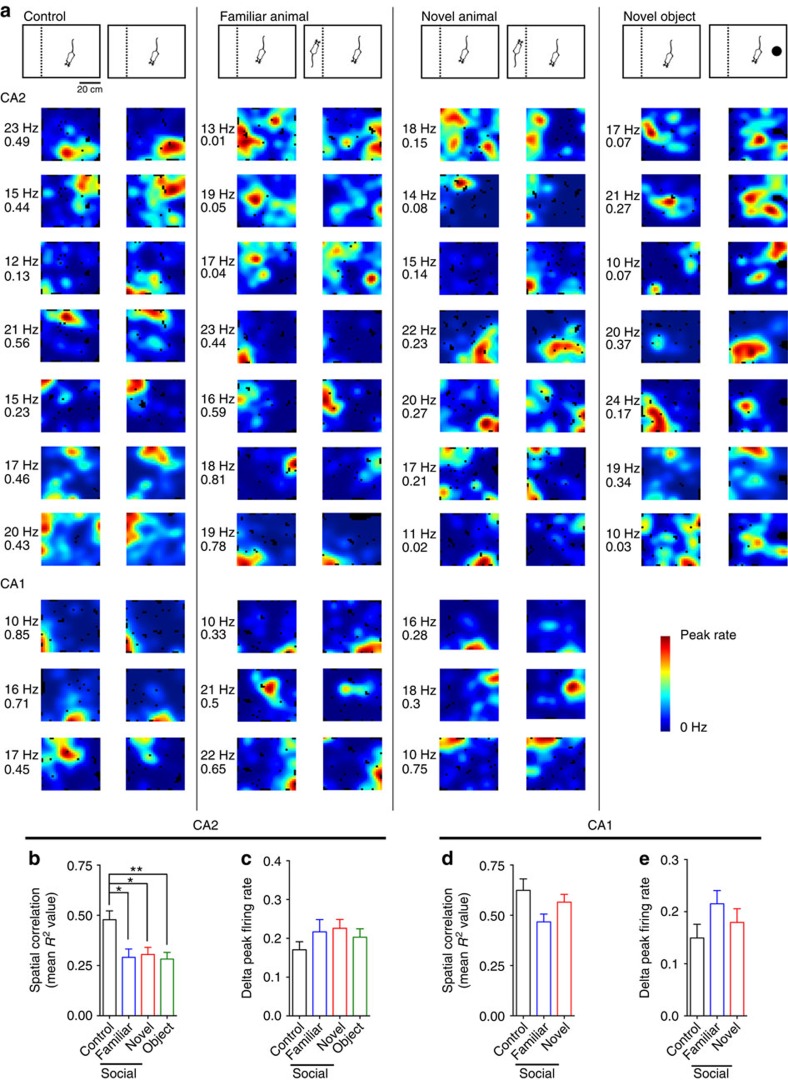
CA2 globally remaps on exposure to social and contextual stimuli.(a) Example place maps for CA2 neurons (top) and CA1 neurons (bottom) on exposure to each of the four conditions depicted in the diagrams on top. In the first epoch of each of the four conditions, animals explored the open-field arena with no stimulus present. In the second epoch, animals were exposed to no stimulus (control), a familiar rat, a novel rat or a novel object. Stimulus rats were placed in a clear plexiglass chamber and novel objects were placed inside the open-field arena. For each place field map pair, the peak firing rate for the pair (in Hz, top) and the spatial correlation value (bottom) is listed to the left and heat maps for both place field maps are scaled to the peak rate. (b,c) Analyses of remapping of firing fields by CA2 neurons on the four exposures listed, including spatial correlations to measure global remapping (b) and changes in peak firing rates (c). CA2 place cells globally remapped their representation of space in response to familiar and novel rats and novel objects compared with control conditions with no social exposure (H(3,168)=13.32, P<0.01, Kruskal–Wallis test with Holm–Bonferroni correction; Fig. 3a,b, n=31, 37, 54 and 46 CA2 neurons for control, familiar social, novel social and novel object exposures). Global remapping occurred in CA2 without any significant changes in peak firing rate (H(3,168)=1.649, P>0.05, Kruskal–Wallis test, same n values as b). Spatial correlation values (d) and changes in peak firing rates (e) for CA1 neurons, which showed no global remapping (H(2,144)=5.434, P=0.0661, Kruskal–Wallis test, n=28, 59 and 57 neurons for control, familiar social and novel social, respectively) or changes in peak firing rate (H(2,144)=2.895, P>0.05, Kruskal–Wallis test, same n values as d) during control or social stimulation. *P<0.05; **P<0.01. Error bars are s.e.m.